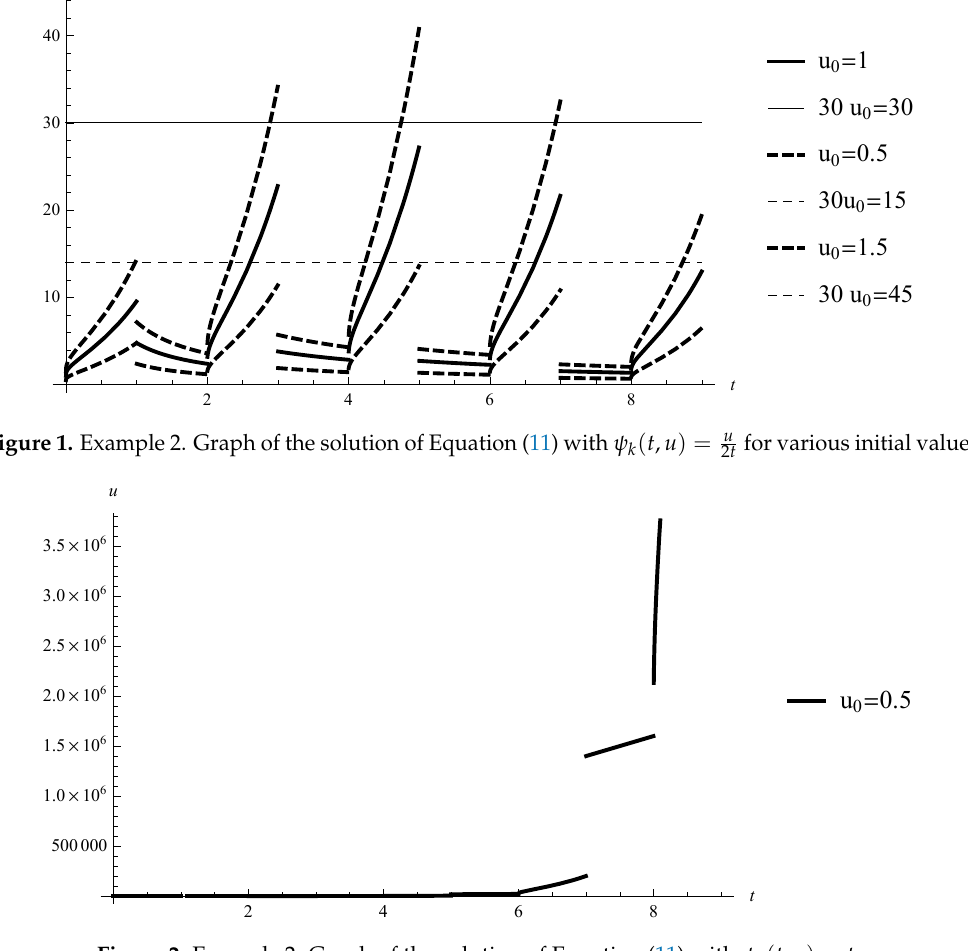
Figure 2. Example 2. Graph of the solution of Equation (11) with ψ k ( t , u ) = tu